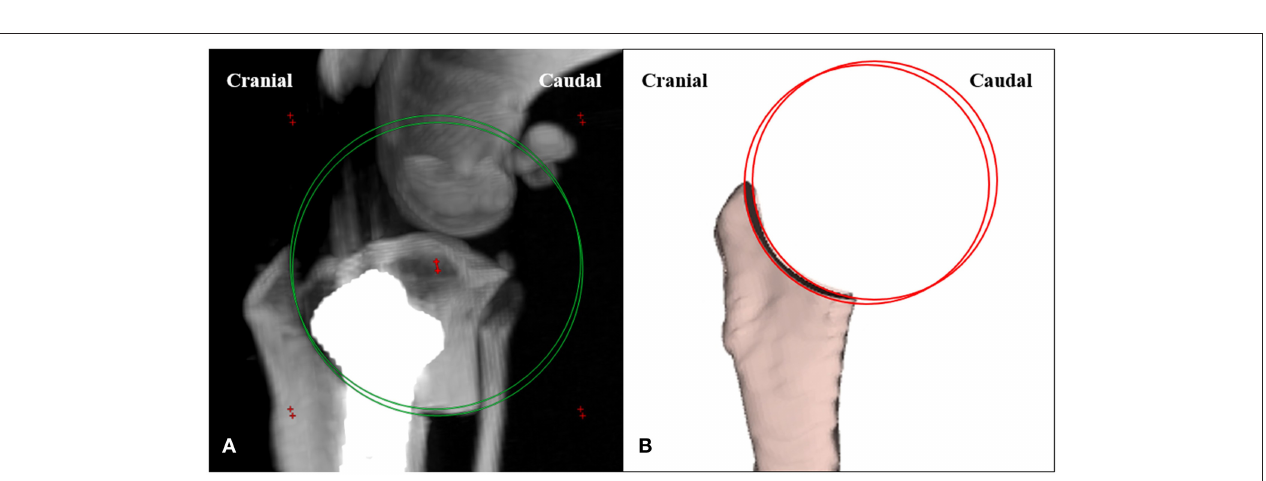
FIGURE 4 | Measuring the angulation of osteotomy for inclination. (A) The angle of intersection of a line parallel to the osteotomy and a line with accurate orientation of the osteotomy is defined as the osteotomy inclination angle. (B) Positive angulation is defined as the direction of the osteotomy proximally from the medial cortex to the lateral cortex. Negative angulation is defined as the direction of the osteotomy distally from the medial cortex to the lateral cortex.